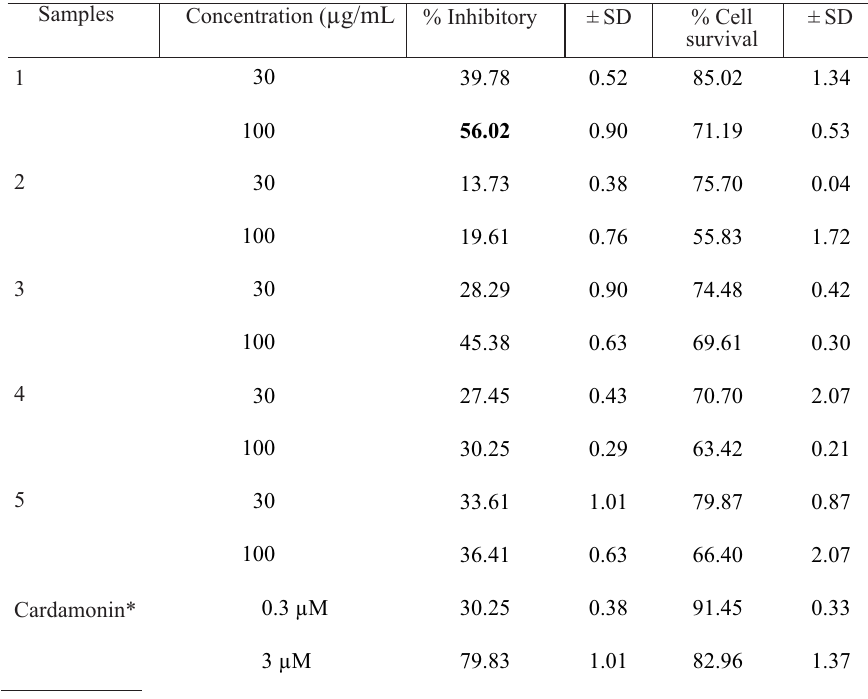
Table 2. Inhibitory effect of the isolated compounds on NO